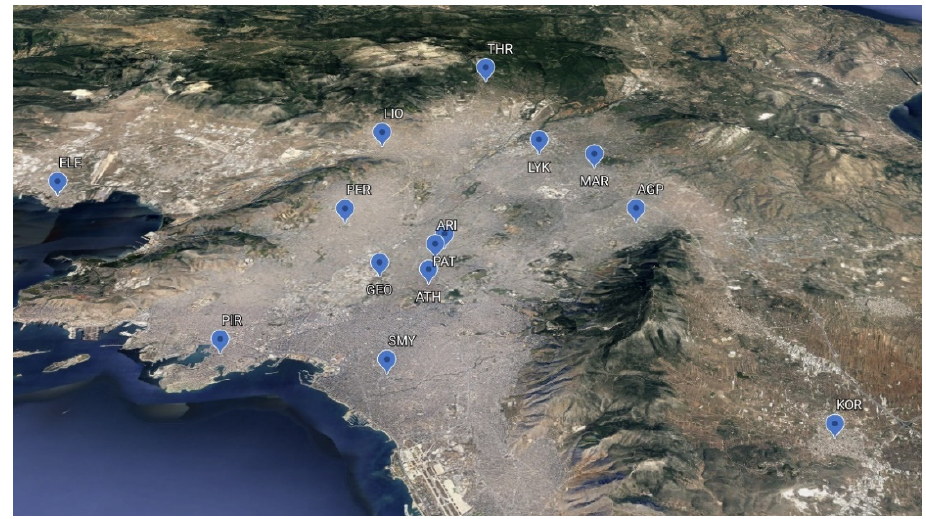
Figure 1. Spatial distribution of the air-quality-monitoring sites in the area of study.